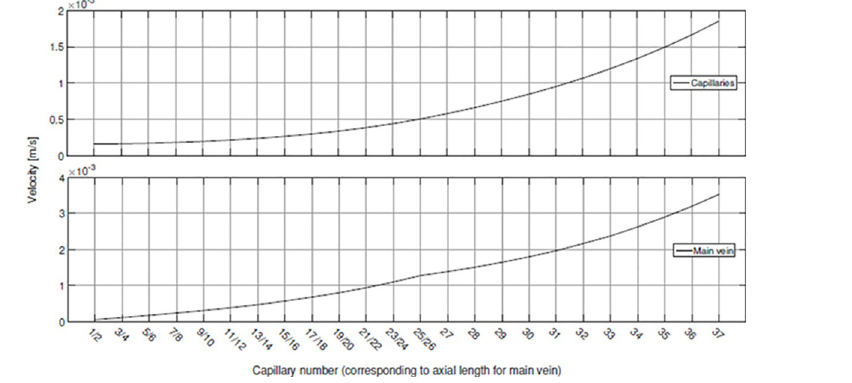
Fig 13. Development of O 2 transport velocity in capillaries and main